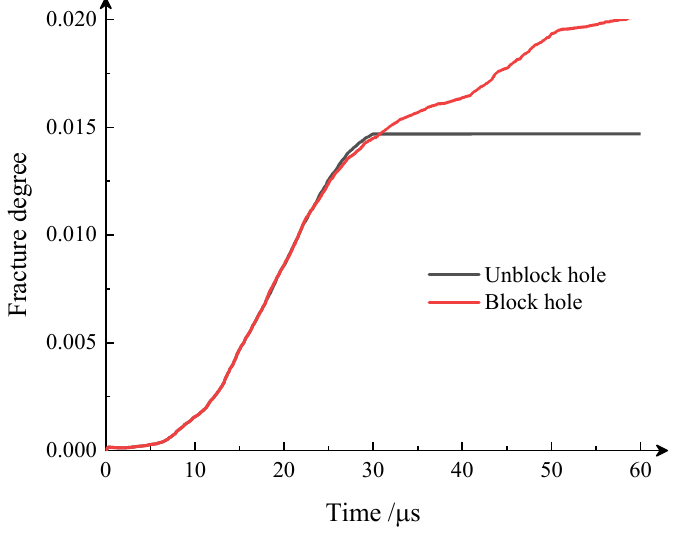
Figure 9. Fracture